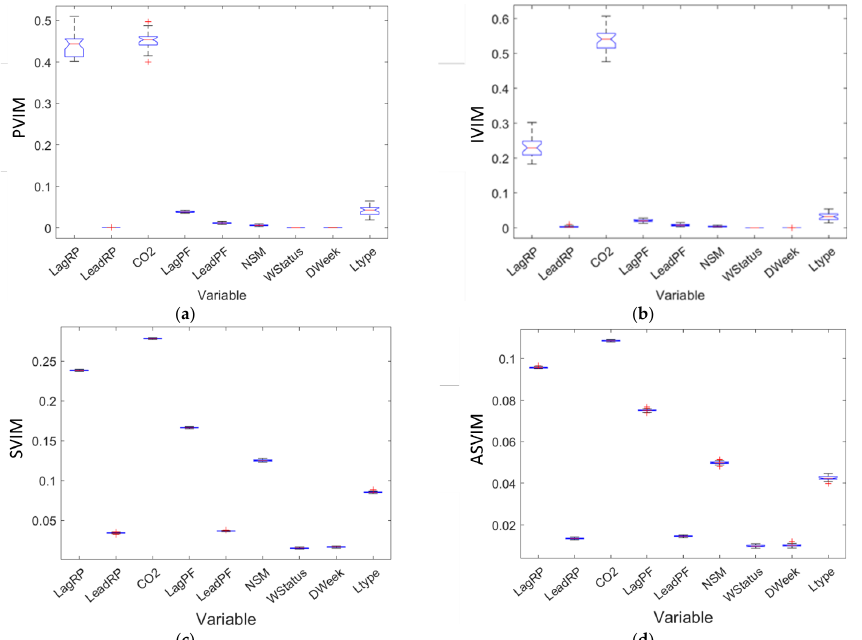
Figure 7. Relative importance of predictors in Case Study 3 based on 100 iterations and 30 runs, showing ( a ) permutation indices (MSE on OOB data), ( b ) impurity indices (OOB data), ( c ) Shapley values (R 2 on test data), and ( d ) approximate Shapley values (R 2 on test data). Predictor ranking are shown in Table 5. The most notable differences are between the random forest using the permutation and impurity criteria and the Boruta algorithm. Bo- ruta (BVIM) ranked LType last (ninth position), whereas all the other measures gave ranked it higher (sixth position). This is interesting because the Boruta algorithm is an iterative version of the random forest using the permutation variable importance meas- ure.